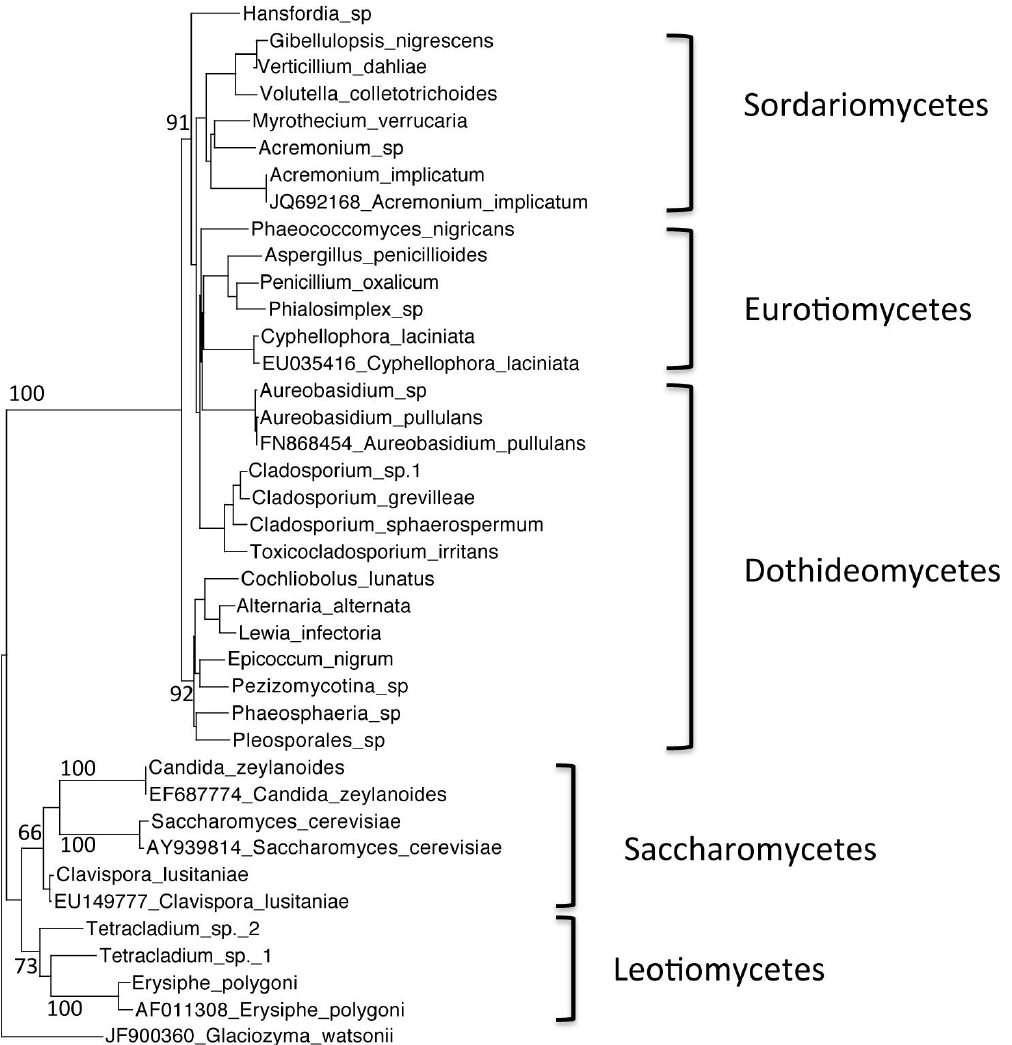
Figure 2. Phylogenetic tree of Warren Cave species belonging to the phylum Ascomycota, obtained by neighbor-joining analysis of the Internal Transcribed Spacer (ITS) region of the 5.8S rDNA gene, with 100 full heuristic replications. Bootstrap values are as indicated on the tree. Glaciozyma watsonii sequence obtained from GenBank was used as the outgroup, with the GenBank accession number listed. Candida zeylanoides , Saccharomyces cerevisiae. Clavispora lusitaniae , Cyphellophora laciniata , Acremonium implicatum , Aureobasidium pullulans and Erysiphe polygoni sequences obtained from GenBank were used as closest relative reference sequences, with GenBank accession numbers